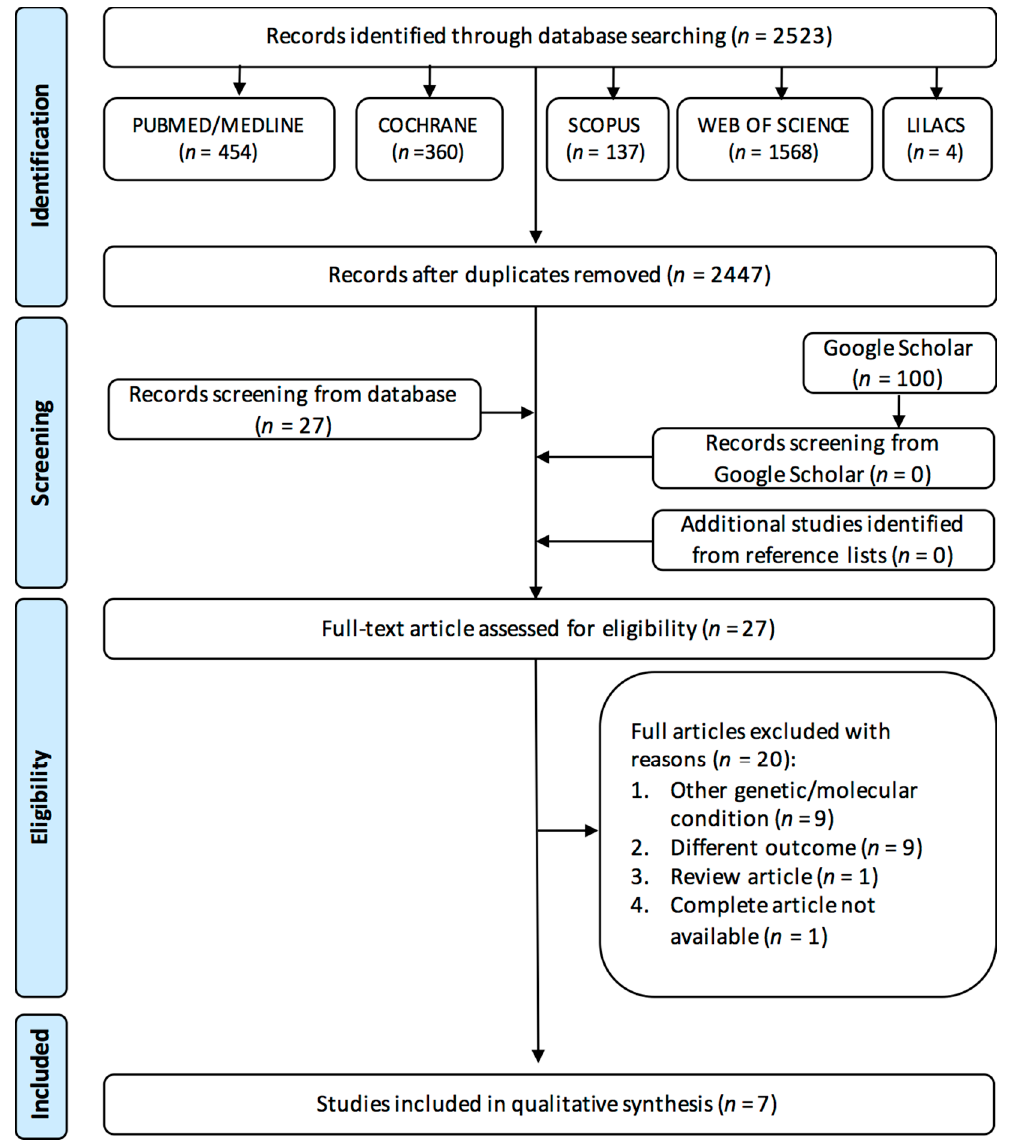
Figure 1. Flow diagram of study selection adapted from Preferred Reporting Items for Systematic Reviews and Meta-Analyses (PRISMA) 2. LILACS: Latin American and Caribbean Center on Health Sciences Information.